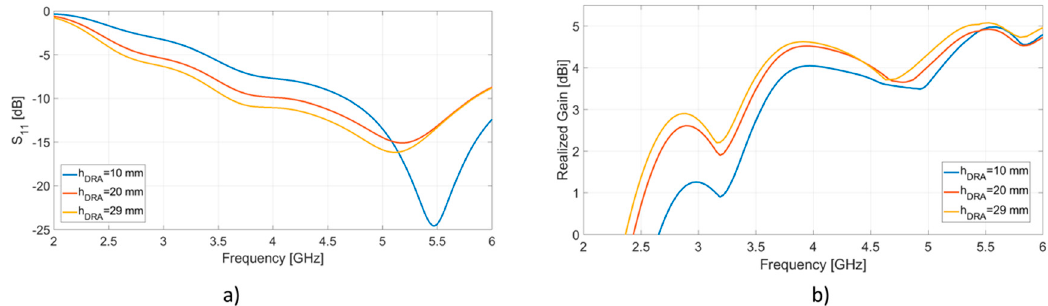
Figure 5. ( a ) Scattering parameter S 11 as the DRA height is varied in the range 10–29 mm, considering h PIN = 17 mm and t = 2 mm; ( b ) Realized gain as the DRA height is varied in the range 10–29 mm, considering h PIN = 17 mm and t = 2